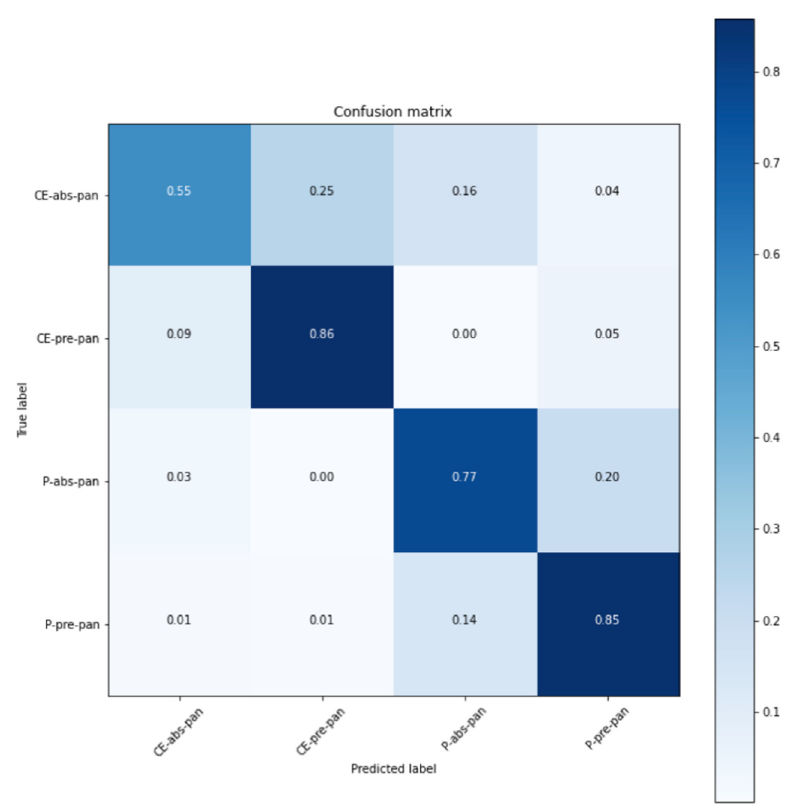
Figure 12. Confusion matrix of ResNet (CE: contrast-enhanced, P: plain).